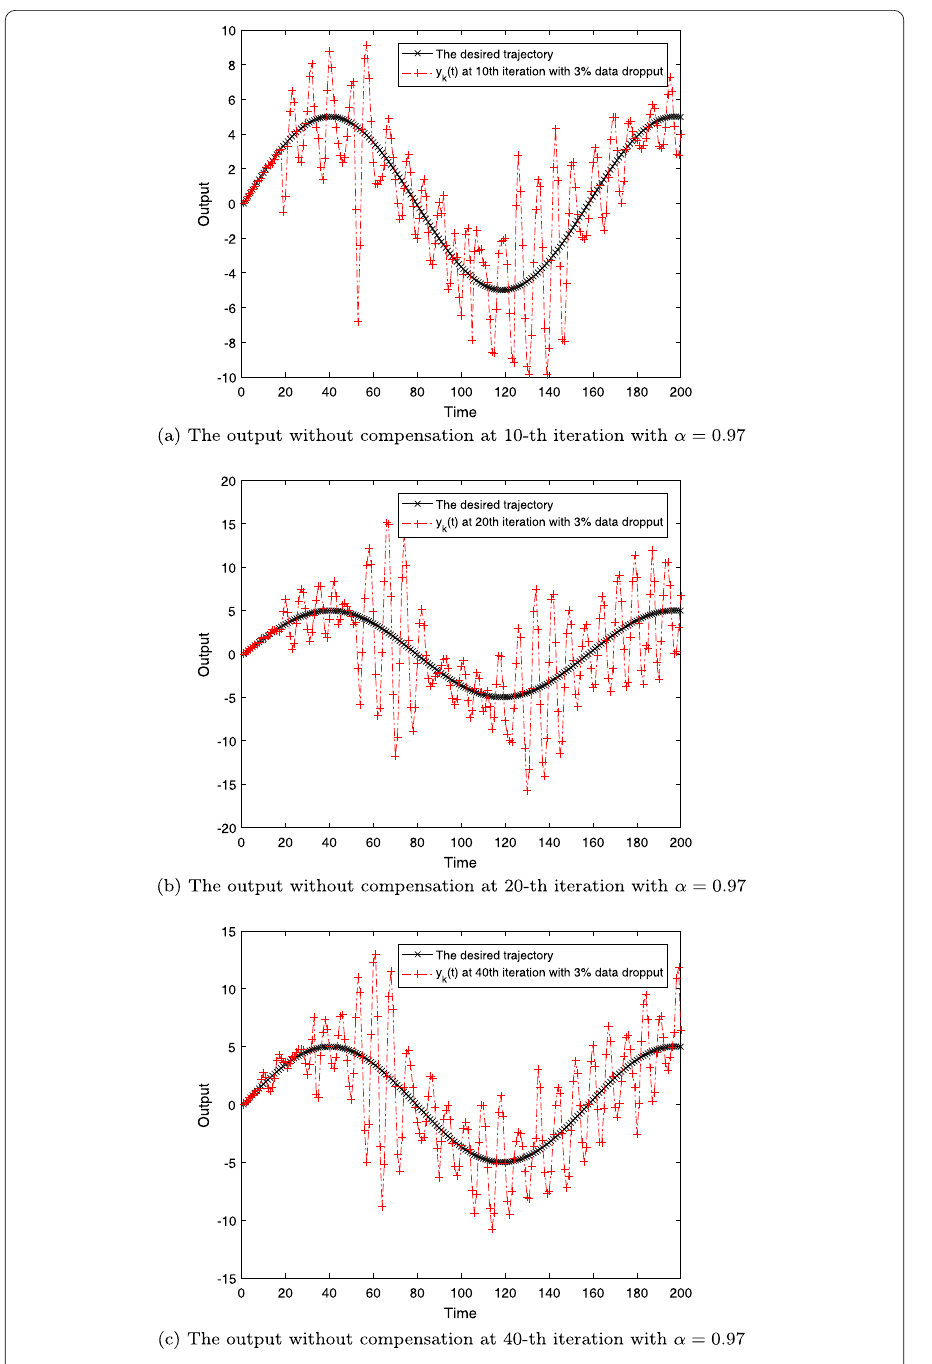
Figure 5 The output without compensation at different iterations with α =